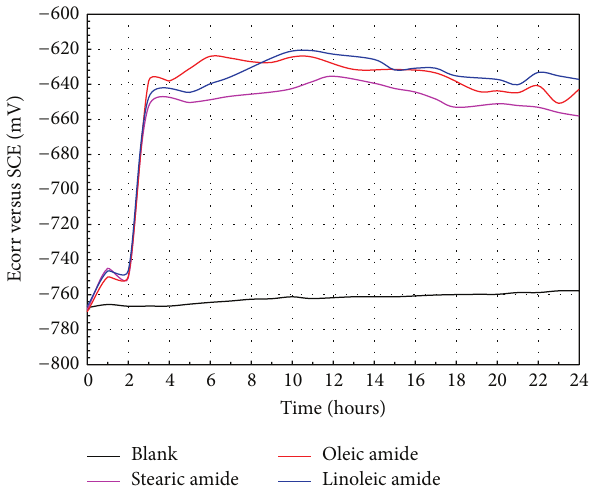
Figure 3: Change of the 𝐸 values as function of testing time for corr 1018 carbon steel in CO 2 -saturated (3% NaCl + 10% diesel) emulsion with and without fatty-amides at 50 ∘